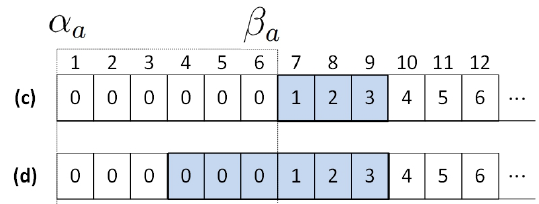
Figure 5. Two different cases of dissatisfaction degree if the dissatisfaction increases the further away it is from the preferred